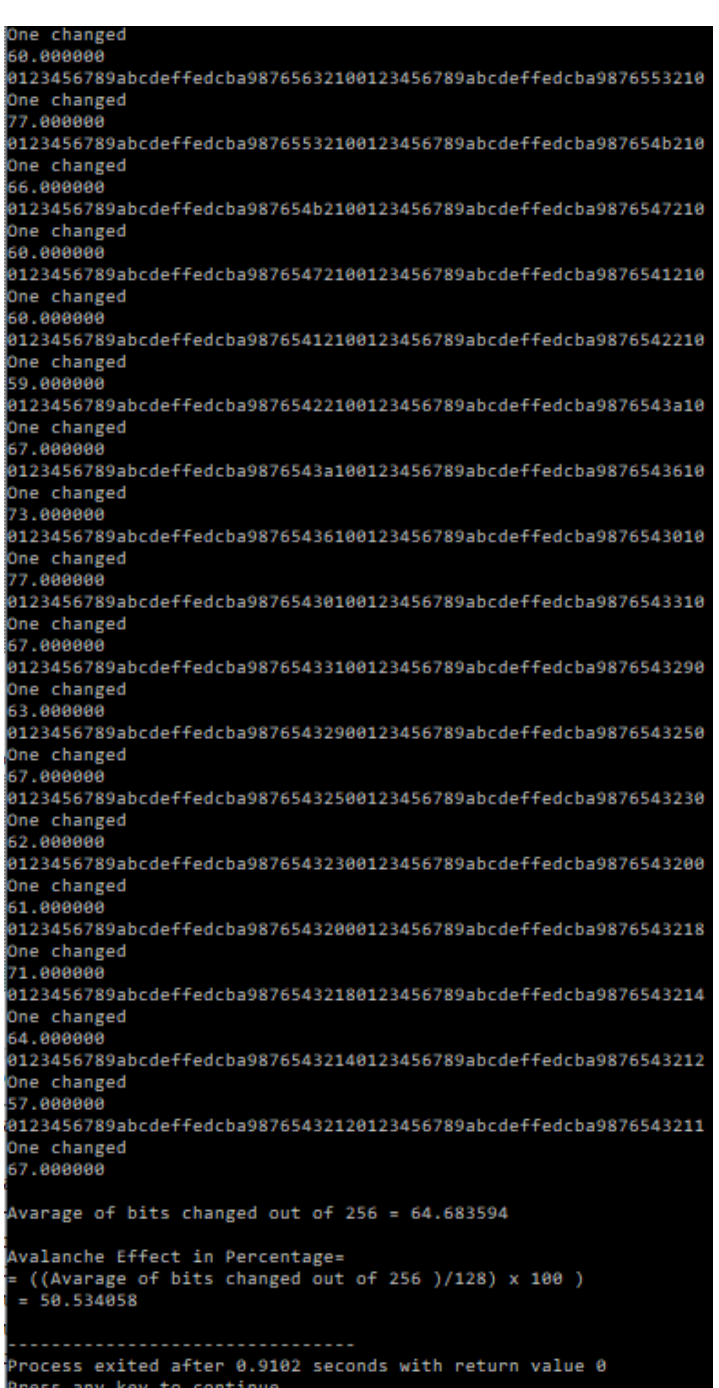
Figure 11. Experimental Avalanche Effect of Mag_Serpent when one bit of a key was